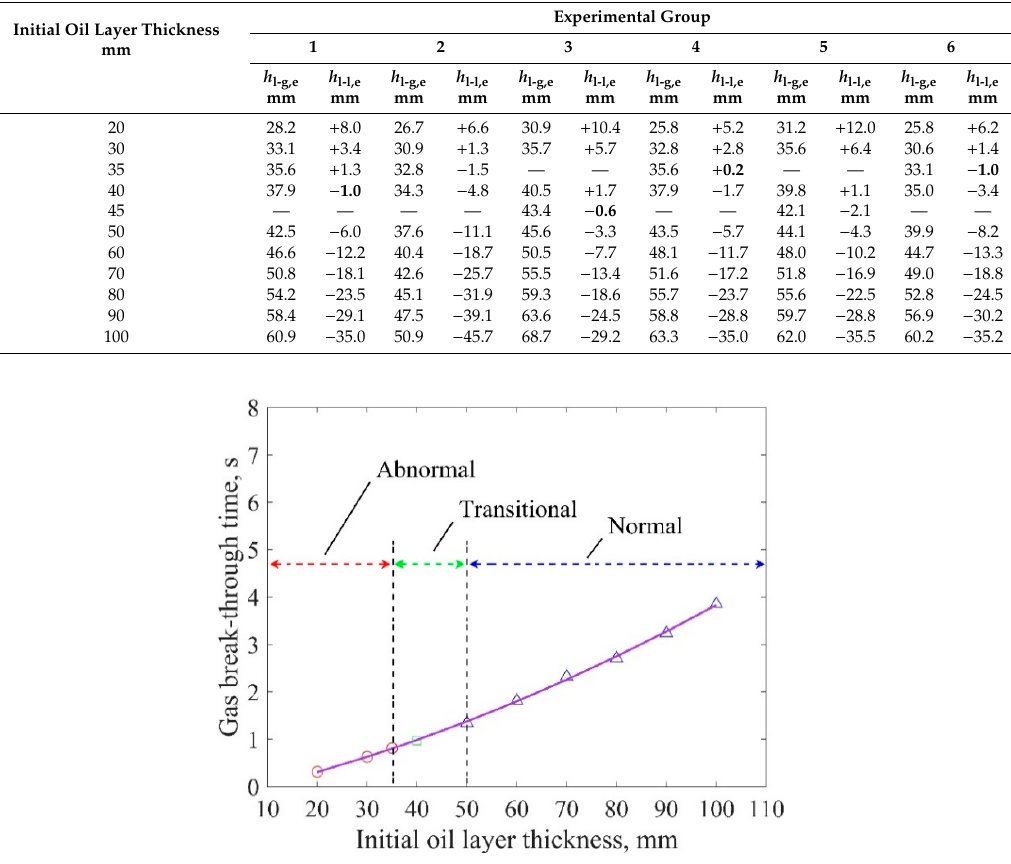
Figure 11. Effect of initial oil layer thickness on the drainage end state. Initial l–l interface level: 10 mm, pressure drop: 0.3 bar, oil viscosity: 0.131 Pa·s.